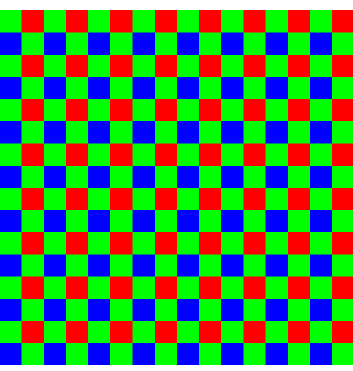
Figure 1. Bayer grid (twice as many green pixels than red or blue pixels) (Sakamoto et al.,